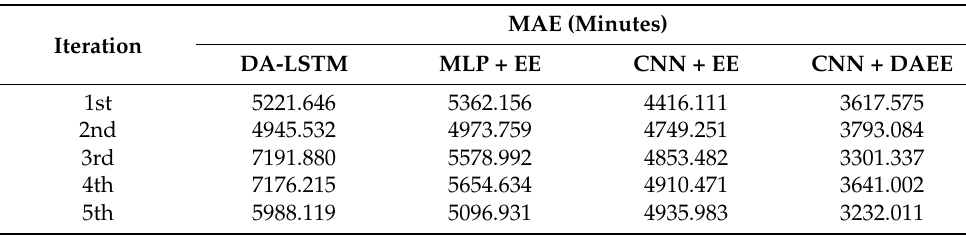
Table 8. Accuracy (MAE) in units of